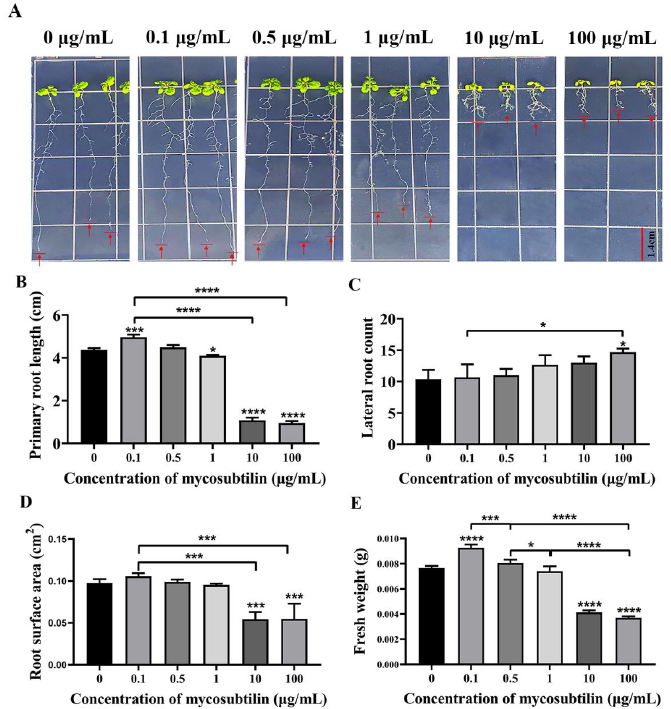
Figure 5. Effect of mycosubtilin on the growth of Arabidopsis seedlings. ( A ) Growth phenotype of Arabidopsis seedlings. ( B ) Effect on primary root length. ( C ) Effect on the number of lateral roots. ( D ) Effect on root surface area. ( E ) Effect on fresh weight. Note: Means ± SEs, n = 50, different “*” indicate significant differences among treatments based on the least significant difference at p ≤ 0.05.